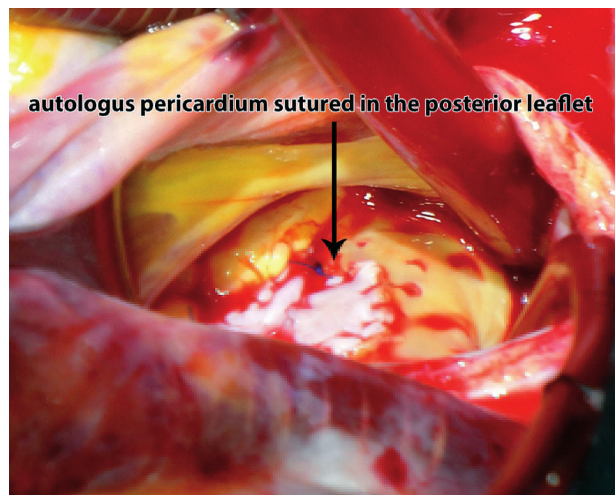
Fig. 2 – Following aggressive debridement of the posterior leaflet and the left atrial wall, the infected zone was resected and replaced with autologous